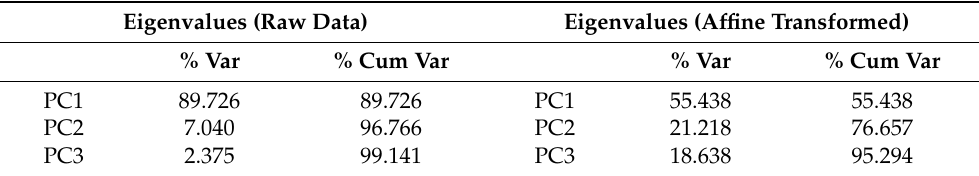
Table 2. Eigenvalues and accumulated variance: a) raw data, and b) transformed